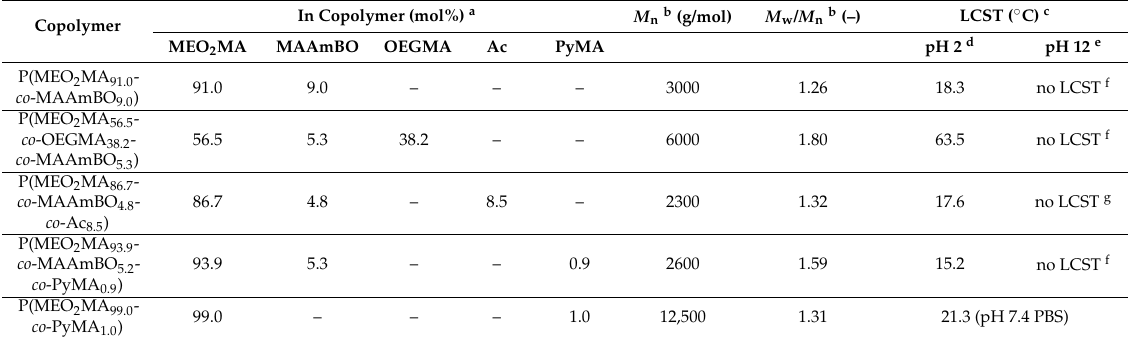
Figure 2. Chemical structure of BOPs and EVOH. MEO 2 MA, two-(2-methoxyethoxy)ethyl methacrylate; MAAmBO, five-methacrylamido-1,2-benzoxaborole; OEGMA, oligo(ethylene glycol) methacrylate; Ac, acrylic acid; PyMA, one-pyrenemethyl methacrylate. Table 1. Characterization of BOPs. LCST, lower critical solution temperature.